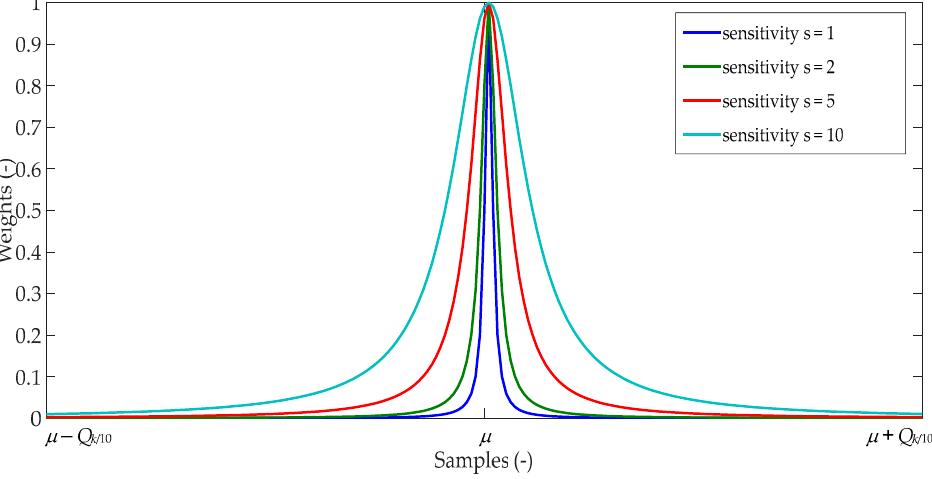
Figure 6. The assignment of weights by using the Bell function in Equation (7) as the membership function.